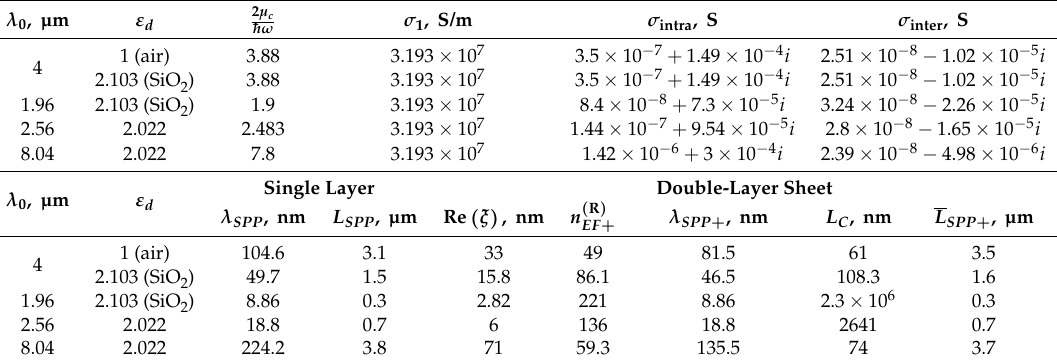
Table 1. The characteristics of SPP generated at the graphene sheets with parameters: µ c = 0.6 eV, τ = 0.9 ps, T = 300 K, ∆ g = 2 nm, and d = 20 nm. λ 0 ,